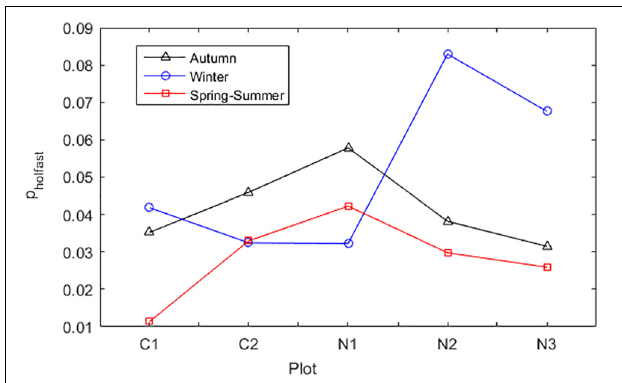
FIGURE 1 | Probability of A. chilense to lose their fronds and survive as bare holdfast (p holdfast ). This probability is dependent on plot and season. Plots were Corral 1 (C1), Corral 2 (C2), Niebla 1 (N1), Niebla 2 (N2), and Niebla 3